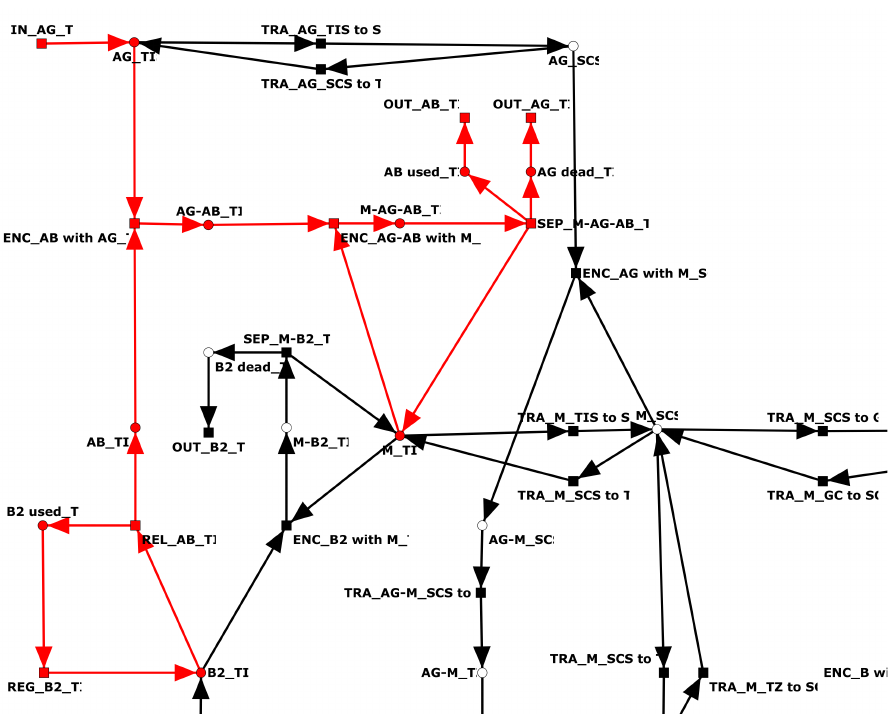
Figure 4. Transition invariant TI-9: production of antibodies. TI-9 is highlighted in red. TI-9 characterizes the production of antibodies (place: AB_TIS ) by plasma B cells (place: B2_TIS ) and the degradation of antigen (place: AG_TIS ) in the tissue by macrophages (place: M_TIS